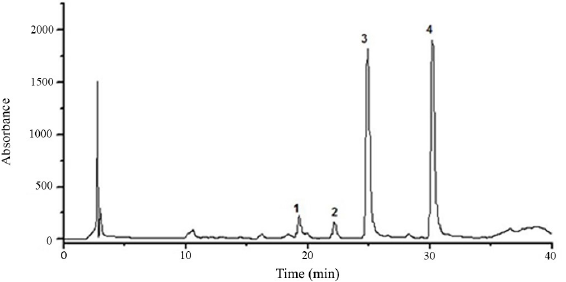
Figure 3 - HPLC-PAD flavonoids profile of the h ydroethanolic extract from seeds of H. courbaril . Phenomenex®